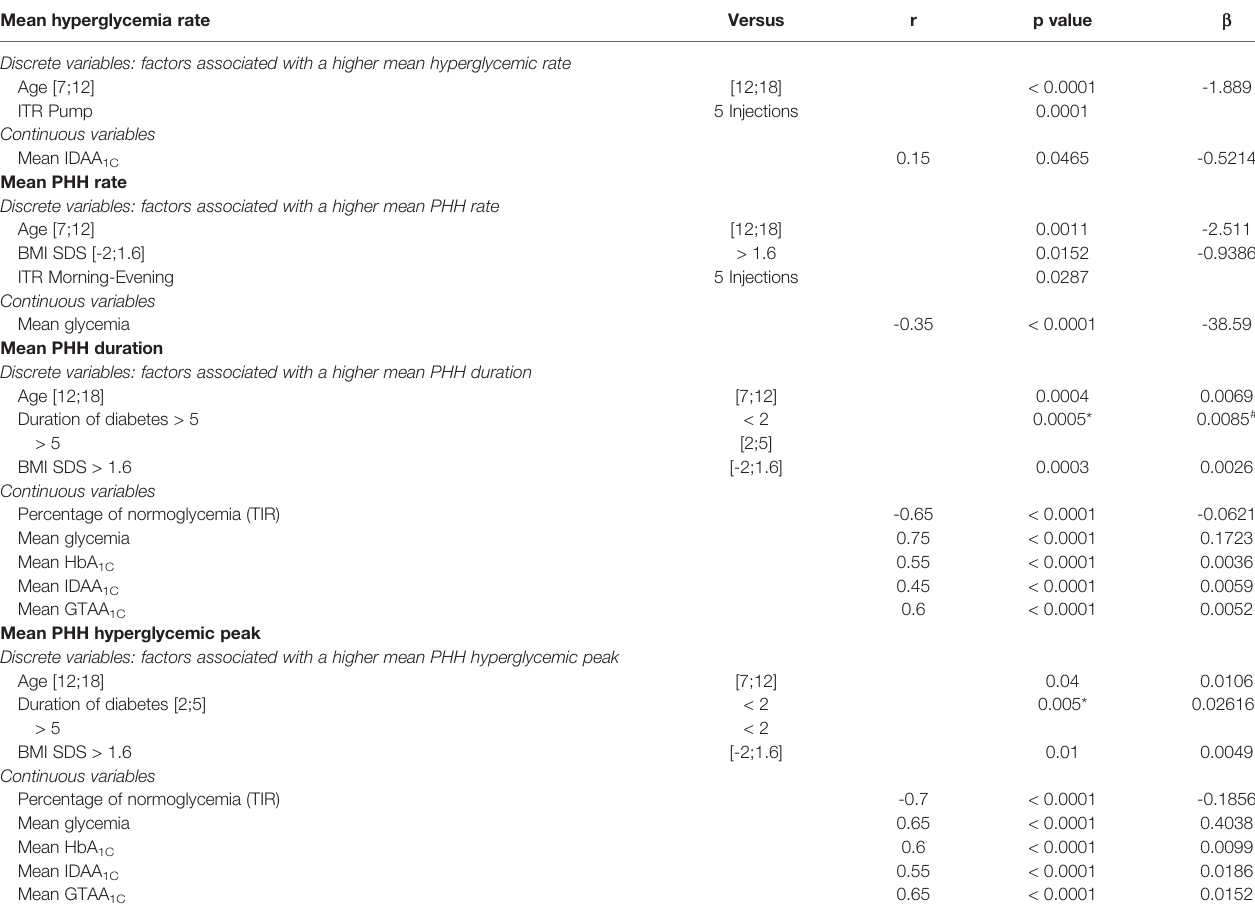
TABLE 2 | Univariate analysis of parameters in fl uencing mean PHH rate, duration and hyperglycemic peak, and mean hyperglycemia rate. Mean hyperglycemia rate